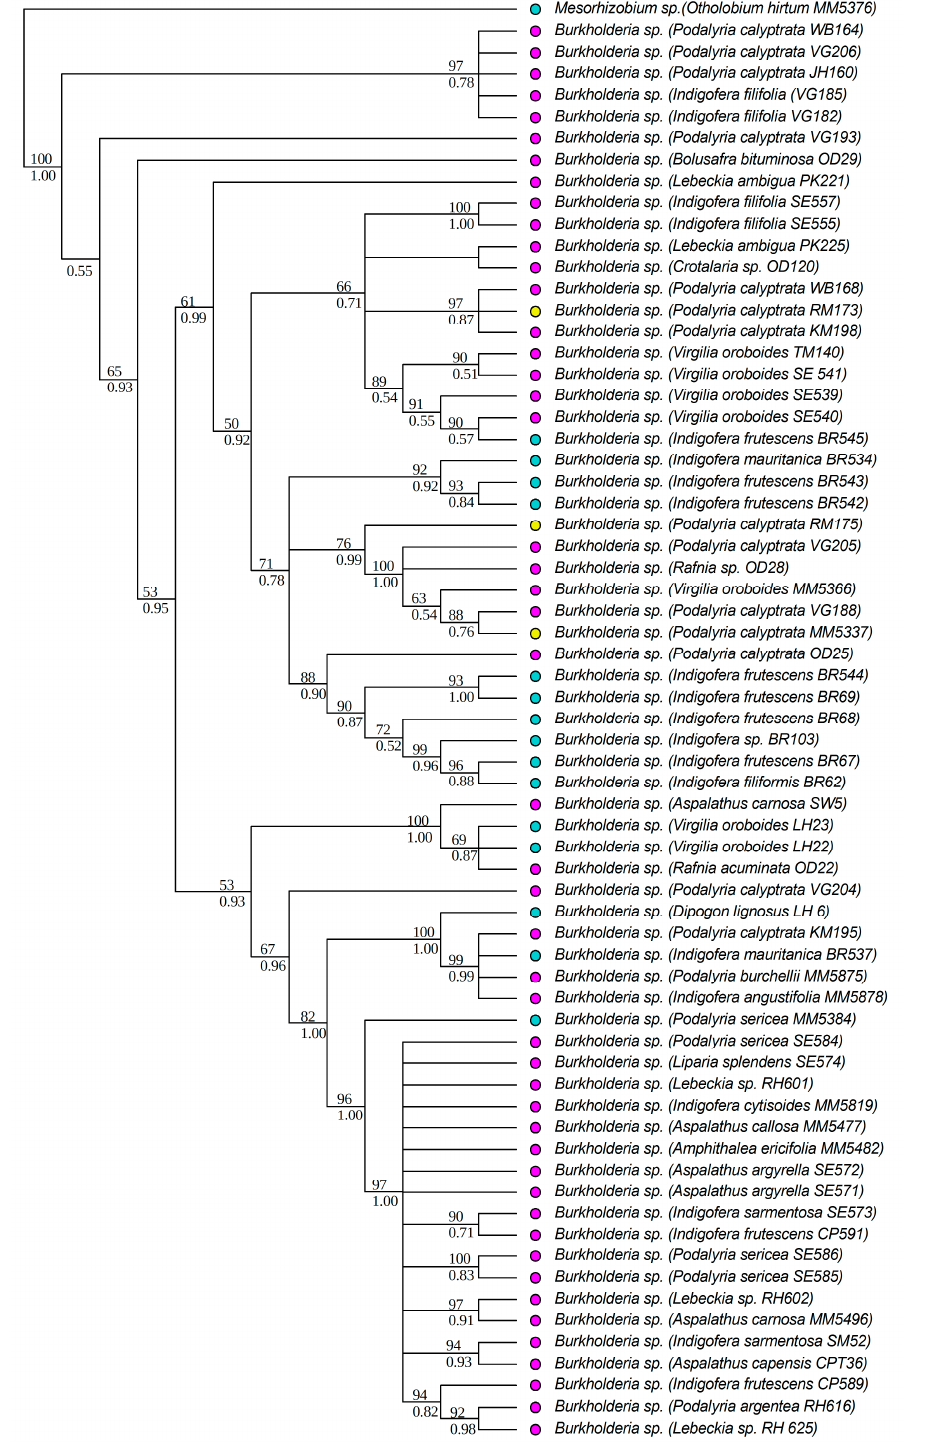
Figure 1. Phylogenetic relationships of Burkholderia strains based on 16S ribosomic RNA (rRNA) and recombinase A ( recA ) data. Names of the legume hosts and the rhizobial strain numbers are in parentheses. Strain numbers with the prefixes OD- (i.e., collector name: Oscar Dlodlo) and MM- (i.e., collector name: Muthama Muasya) are from the study by Lemaire and co-workers [21]. All other strains were newly generated in this study. Maximum likelihood (ML) bootstrap (%) and Bayesian Inference (BI) posterior probabilities are shown above and below nodes, respectively. Colored circles indicate the soil types of the sites where the legumes and their symbionts were collected, blue: granite, pink: sandstone, yellow: shale.